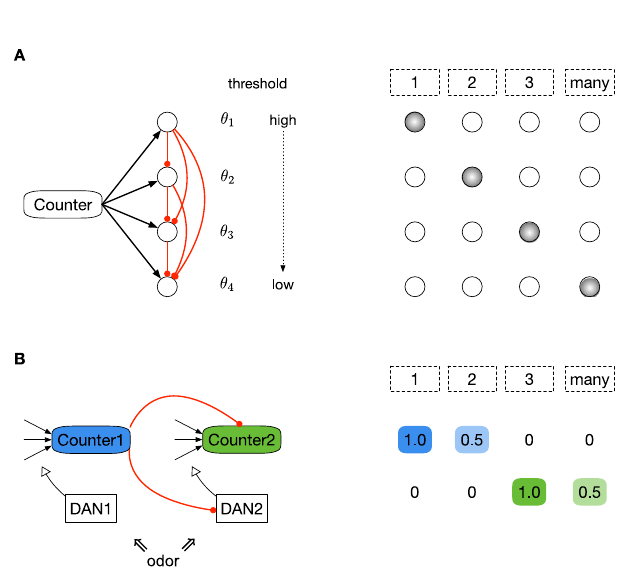
Fig. 5 | Hypothetical read-out mechanisms of the counting neuron. A This modeltranslatesthecontinuous fi ringrateofthe1-2-3-manycounterneuronintoa discrete representation. Because this model uses repetition suppression, larger fi ring rates correspond to less familiar odors. The counter synapses onto four downstream neurons, each with succcessively smaller fi ring thresholds ( θ 1 > θ 2 > θ θ 3 > 4 ). Neurons with larger thresholds inhibit those with smaller thresholds. As a result,eachcountcategorybecomes “ one-hot ” encoded,makingiteasiertomodify behavior. B Thismodelhierarchicallystringstogethercountingneuronstoincrease scalability and the resolution between count categories. In the insect mushroom body, odors activate dopamine neurons (DANs), which modulate synaptic weights onto counting neurons. In this model, there are two counting neurons with two associated DANs. Both counters receive input from encoding neurons, and Coun- ter1 inhibits Counter2 and DAN2. Counter1 encodes categories 1 and 2 with high (1.0) and medium (0.5) responses, respectively. When Counter 1's activity is diminished after the second stimulus experience, the inhibition onto Counter 2 is lifted, allowing Counter2 to encode the two subsequent categories with high and medium